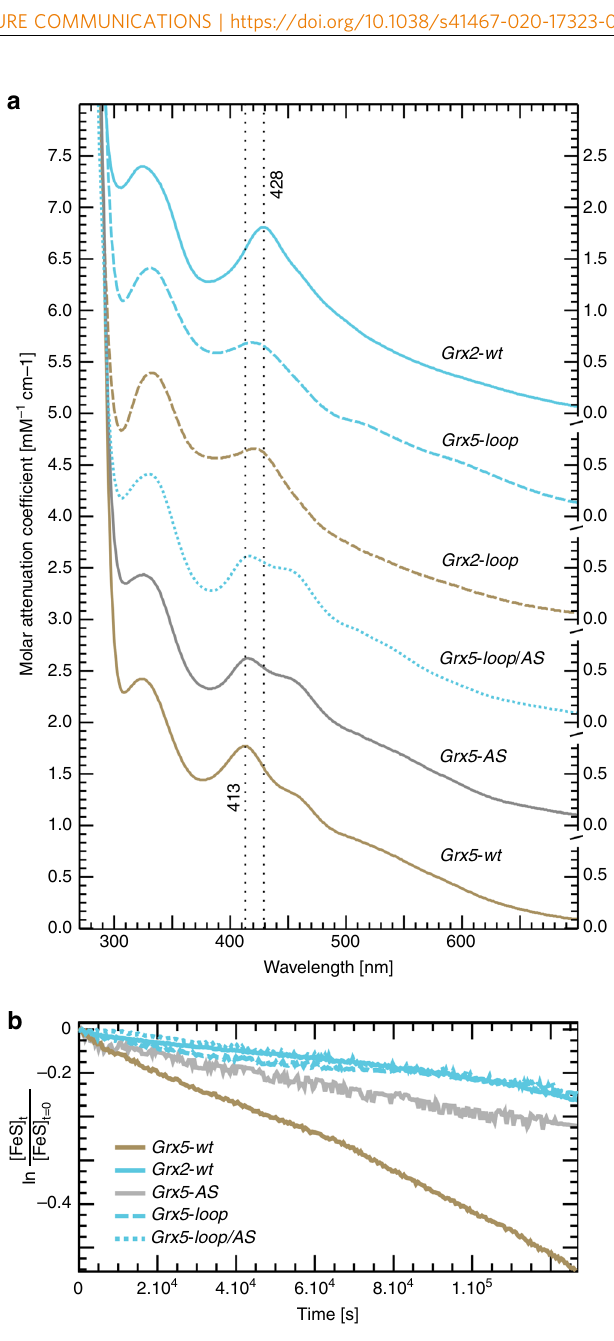
Fig. 4 FeS cluster binding of the wild-type and mutant Grx2 and Grx5. a Spectra of in vitro reconstituted holo-complexes as indicated. The upper spectra were all shifted 1 unit of mM − 1 cm − 1 upwards for clarity. The dotted vertical lines indicate the calculated maximum of the absorption peak of wild-type Grx2 and Grx5, respectively. The spectra were normalized to the molar absorptivity of the proteins calculated from their primary structures using ProtParam. b Integrated fi rst order kinetics of the decay of the FeS clusters of Grx2-wt, Grx5-wt, Grx5-AS, Grx5-loop, and Grx5-loop/AS under ambient conditions. The curves represent the mean of three independent experiments. Initial cluster concentrations ranged from 50 to 150 µ mol l − 1 . Rate constants were obtained from the slope of the curves following linear regression. [FeS] t is the cluster concentration at time point t, [FeS] t = 0 the initial cluster concentration. Blue curves represents the proteins with the CxxC/S-type loop, brown curves the proteins with the CGFS-type loop, the gray curve Grx5 with the CSYC active site of Grx2. Source data are provided as a Source Data fi